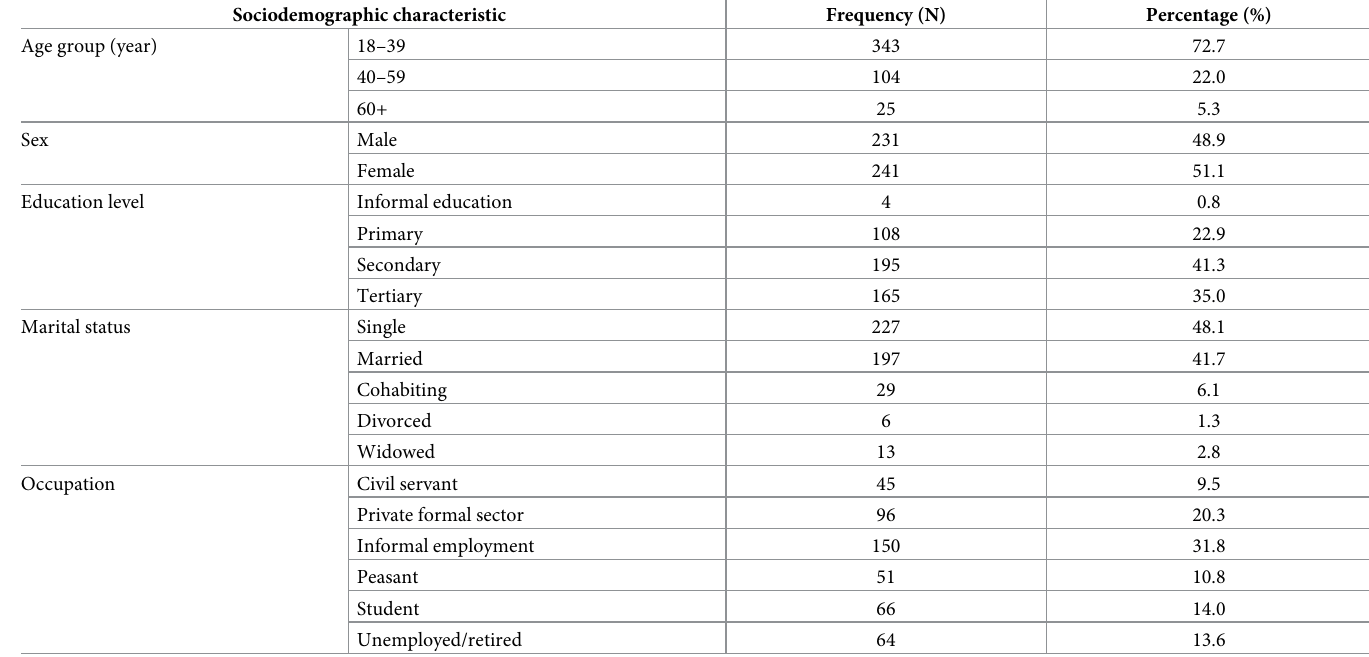
Table 1. Distribution of study participants according to sociodemographic